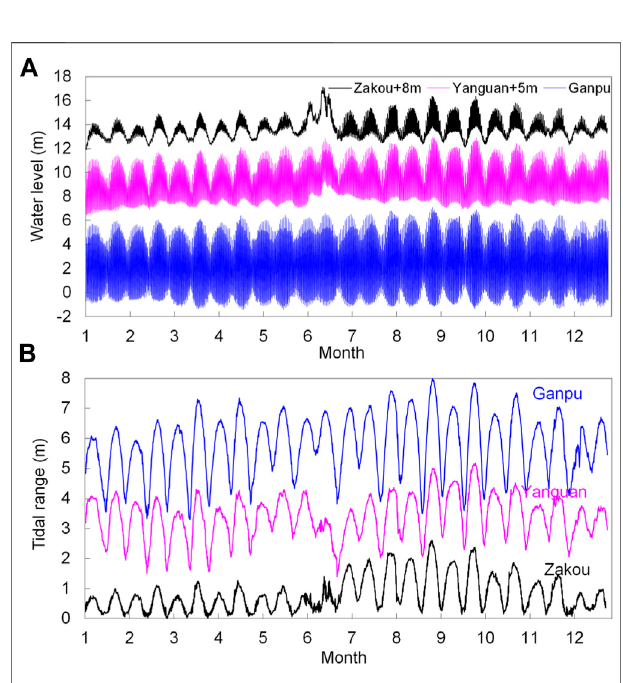
FIGURE5 | Time seriesofwaterlevels (A) and tidal ranges (B) at Zakou, Yanguan and Ganpu in 2015.